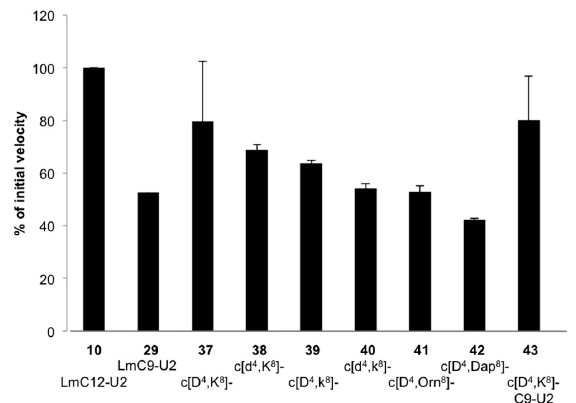
Figure 5. Effect of conformational constraints on HslV activation by HslU C-terminal peptides. HslV activity was measured in the presence of various cyclic analogues of LmC12-U2 and LmC9-U2. Values are expressed as percentage of initial velocity relative to compound LmC12-U2.